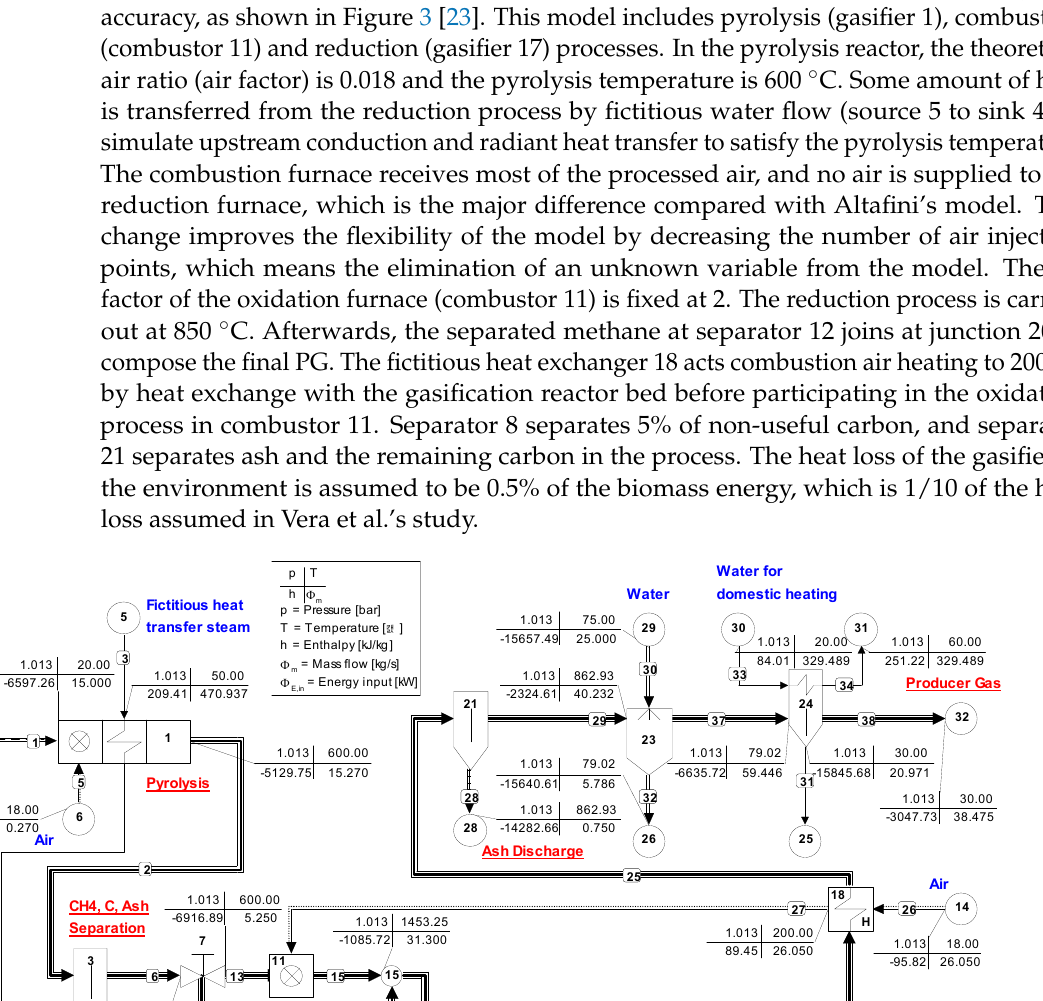
Table 2. Comparison results of the reconstruction model and the original literature. Model